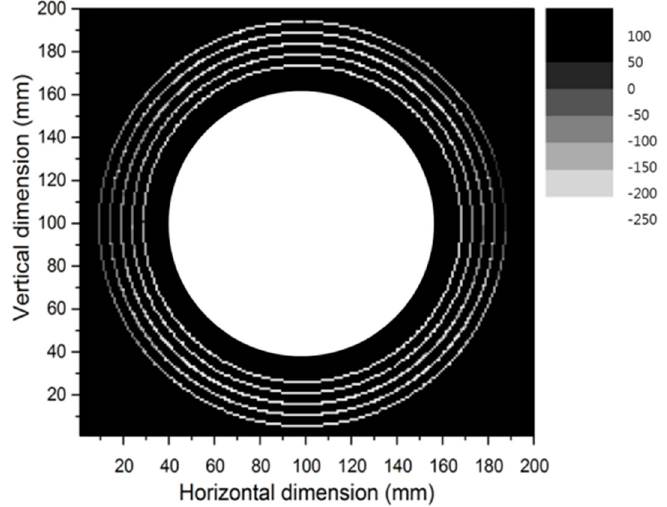
Figure 11 . Strain distribution on the bearing plate from OFDR sensor under 10 t loading.